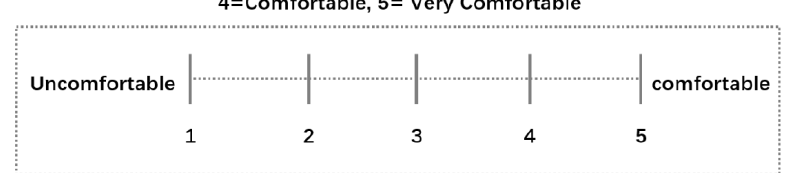
Figure 7. Subjective psychological evaluation scale.